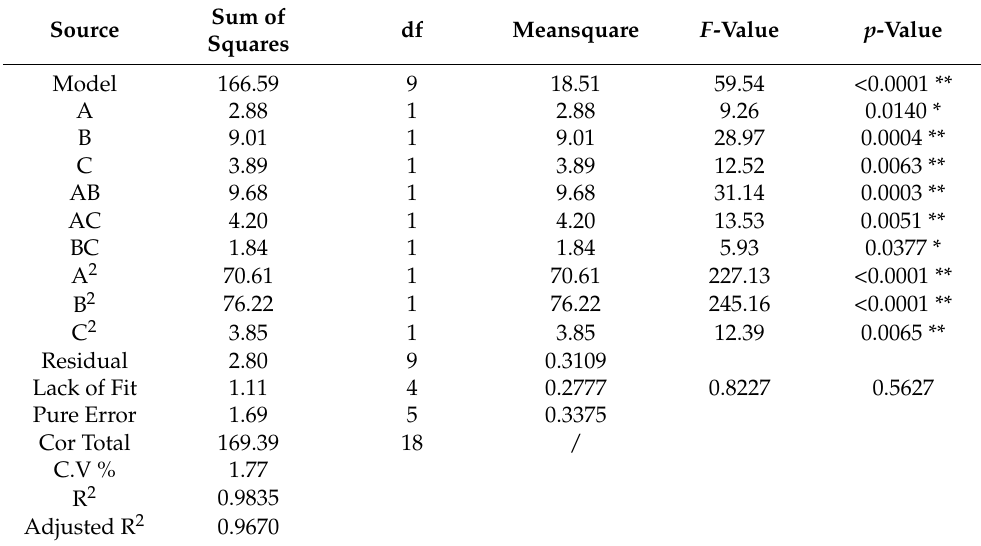
Table 4. One-way Analysis of variance (ANOVA) of model for the yield of Cornus officinalis